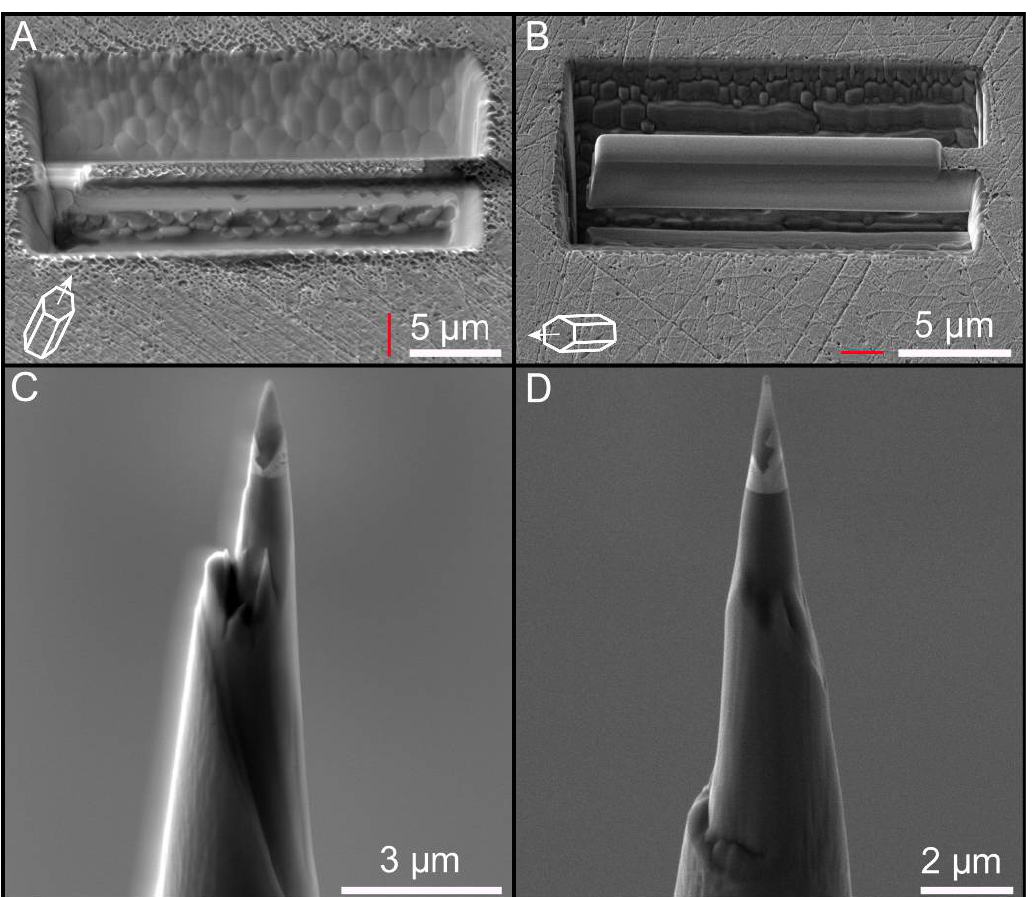
Figure 2. Example of focused ion beam (FIB)-SEM specimen preparation of calcite. ( A , B ) Sample wedges on a section nearly perpendicular ( A ) and almost parallel ( B ) to the {0001} plane, containing the c -axis of calcite; wire frame cartoons indicate the orientation of the calcite c -axis relatively to the position of the wedge, and red lines represent the orientation an d thickness (to scale) of the IOM; ( C , D ) Examples of atom probe tomography (APT) tip specimens fabricated from the sections extracted from wedges on A and B, respectively.